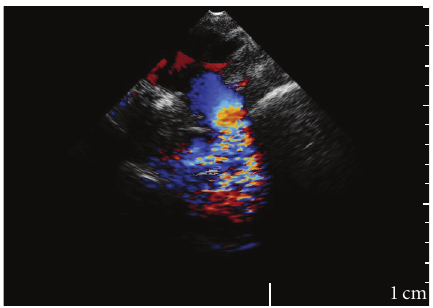
Figure 1: Transthoracic suprasternal view with a turbulent flow below the origin of subclavian artery.